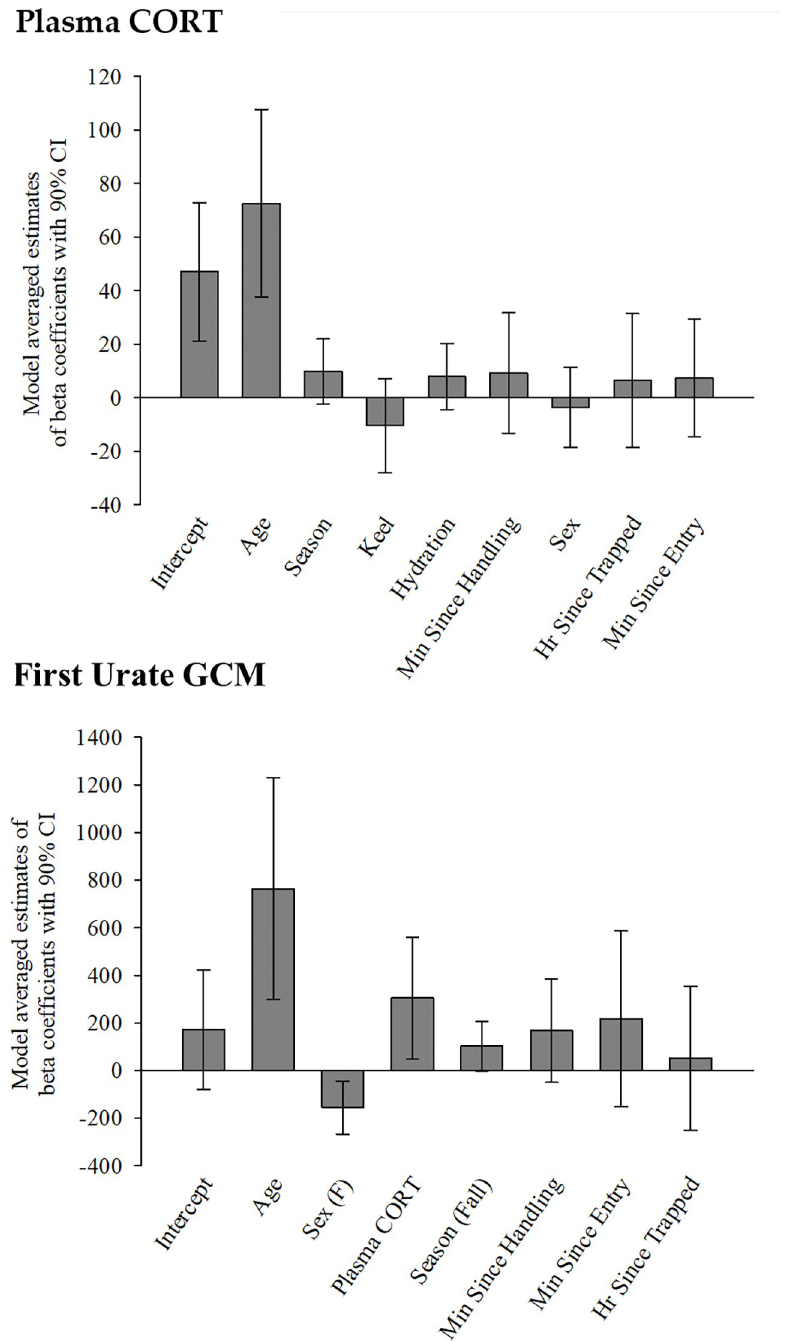
Fig 5. Relative influence of predictor parameters on (A) plasma corticosterone (CORT) values, and (B) urate glucocorticoid metabolite (GCM) values in wild California condors. Model averaged estimate of beta coefficients for all top model parameters with error bars depicting 90% confidence intervals. Parameters with confidence intervals including zero do not have sufficient support for predicting the response variable